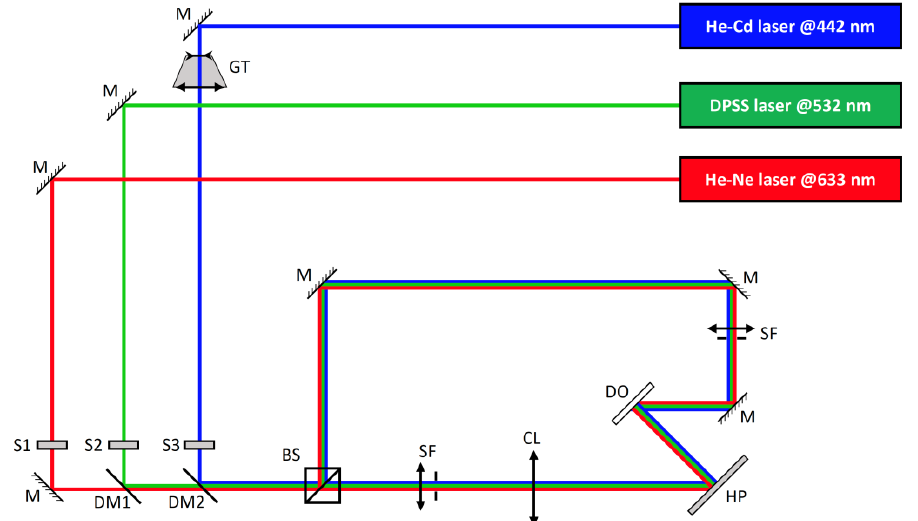
Figure 2. Recording setup diagram. GT is the Galileo telescope, M are the broadband mirrors, S1–S3 are the shutters for each laser, DM1 and DM2 are the dichroic mirrors, BS is the beam splitter, SF is the spatial filtering stage (microscope objective lens + pinhole), CL is the collimating lens, HP stands for the photopolymer and DO represents the diffusing object.